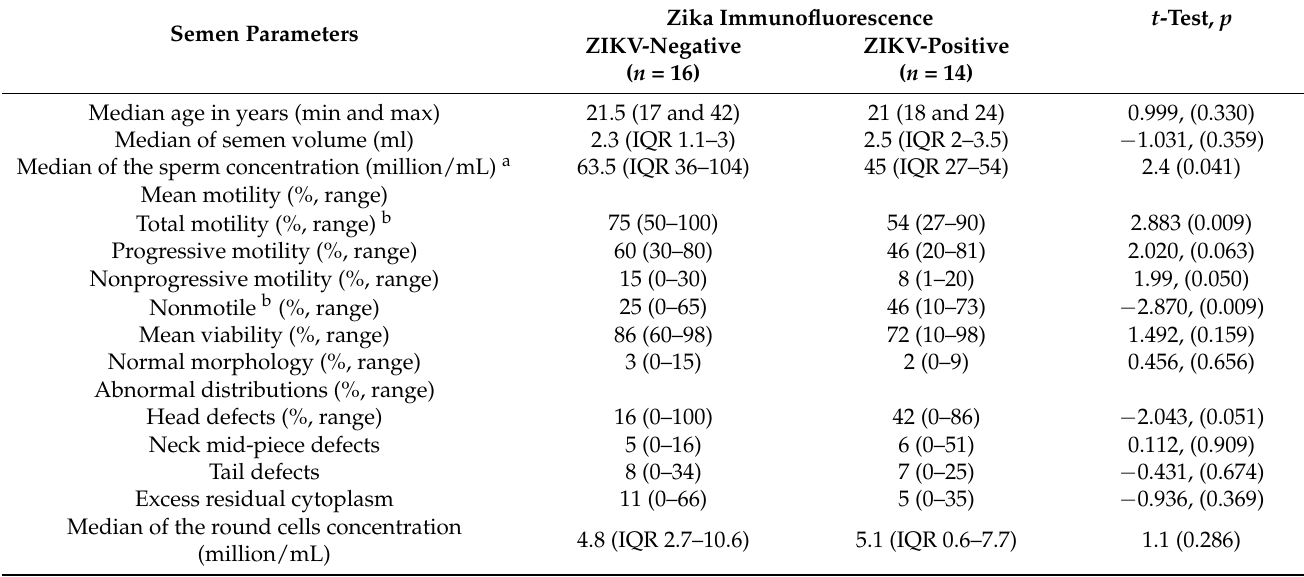
a great percentage of sperm with head defects in specimens from ZIKV-positive (42% vs. 16%, p = 0.054) (Table 2). Table 2. Comparison of semen parameters in specimens collected from ZIKV-positive and ZIKV-negative subjects according to the 2010 World Health Organization laboratory manual for the examination of human